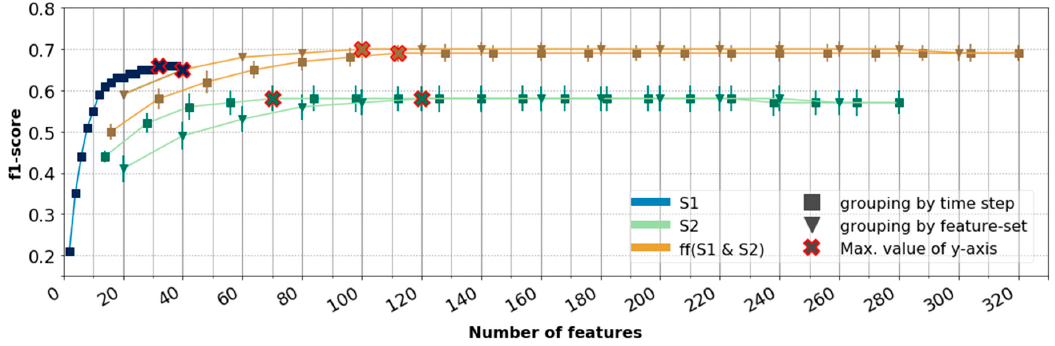
Figure 11. Feature learning curves of time-wise and variable-wise gFFS based on only optical ( S1 ), only, SAR ( S2 ), and optical-SAR feature stacking ( ff(S1&S2) ).